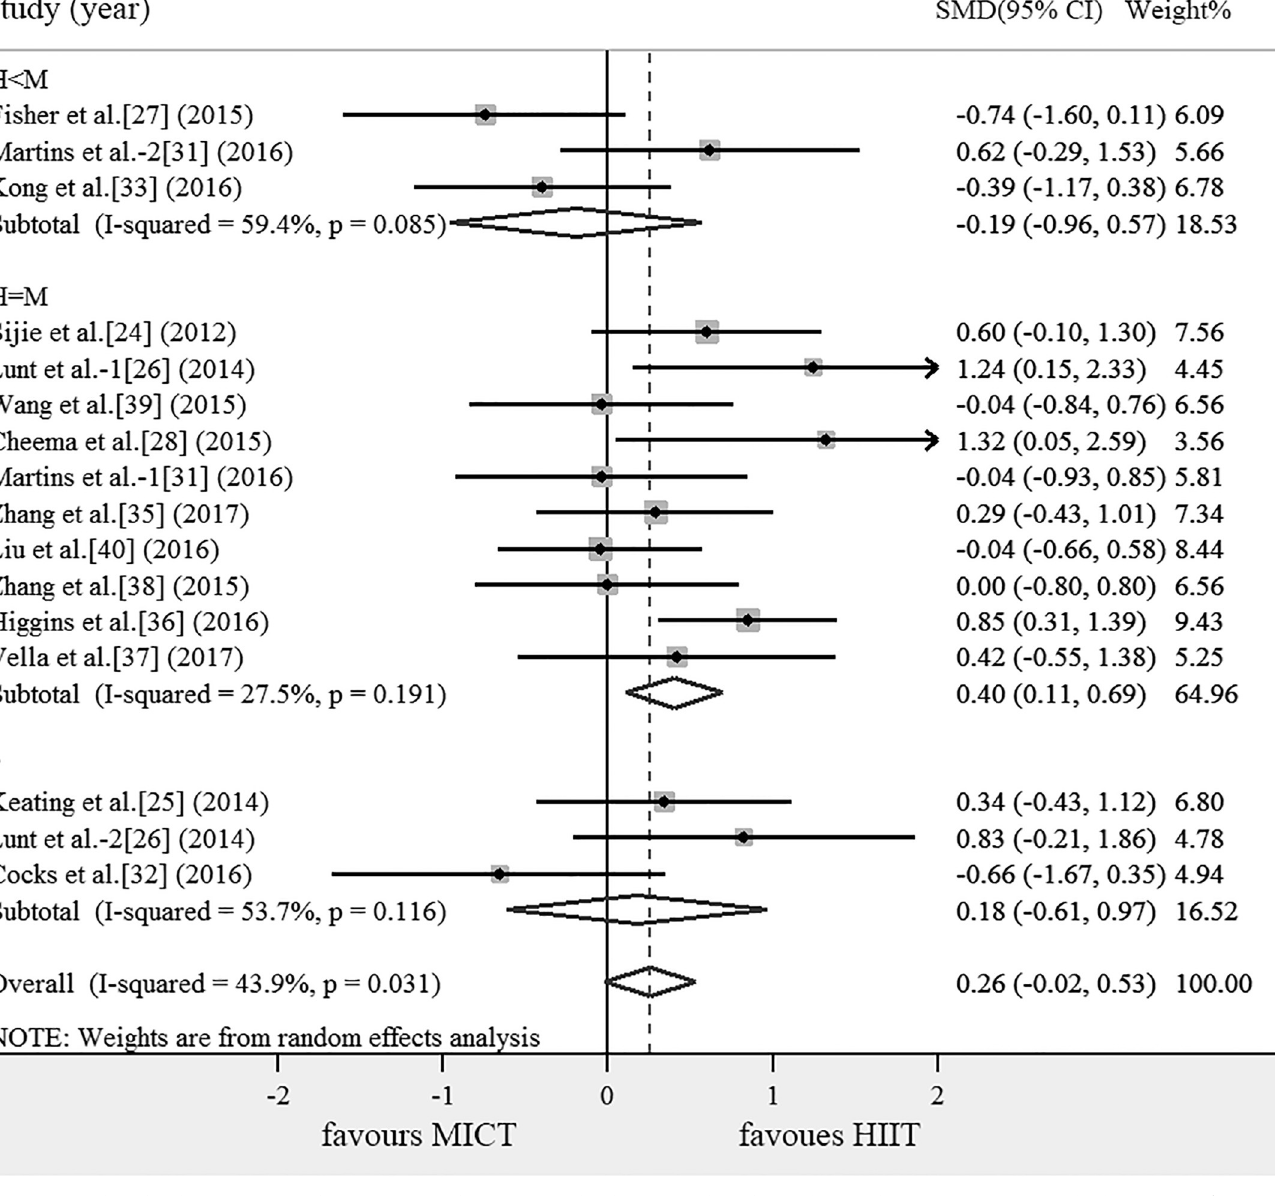
Fig 3. Meta-analysis for the comparison of HIIT vs. MICT for VO 2max with subgroup analyses for studies employing H = M, H < M and ? than MICT. The positive value of X axis indicated that HIIT was more effective than MICT in improving VO 2max . Lunt et al.-1 and Lunt et al.-2 were two different HIIT methods were used in one article. Martins et al.-1 and Martins et al.-2 were two different HIIT methods were used in one article. H = M: Energy expenditure of HIIT equal to MICT; H < M: Energy expenditure of HIIT less than MICT; ?:Not mentioned in the article and the results can not be used to calculate the energy consumption.